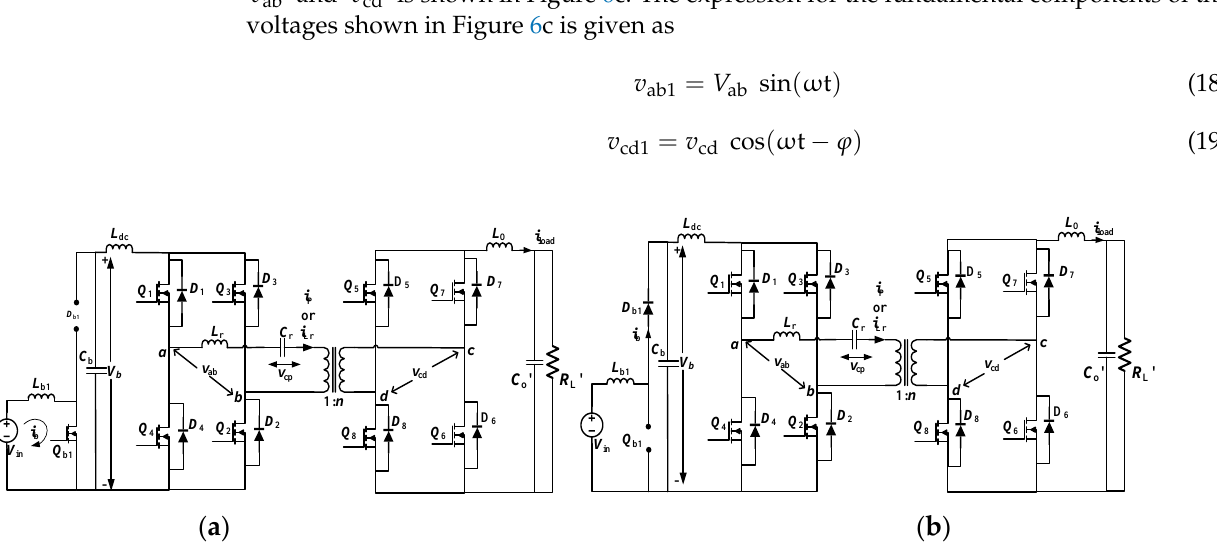
Figure 5. ( a ) CFIBDC Converter with switch Q b1 conducting in FM ( b ) CFIBDC Converter with switch Q b1 off.